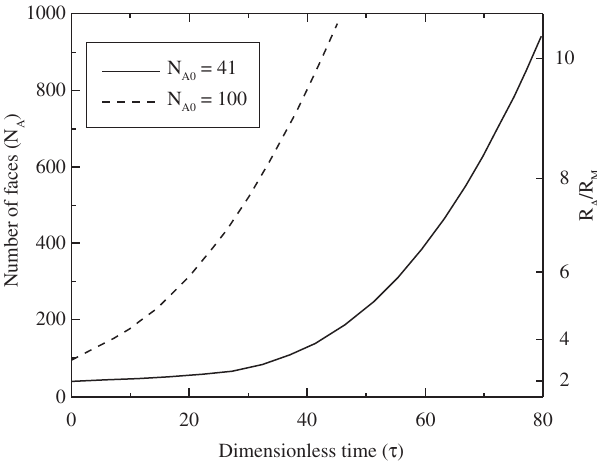
Figure 5. Increase in the number of grain faces, N sionless growth time, τ , for abnormal grains with different initial number of faces, N = 41 and N = 100. Predictions based on Equation 15. A0 A0